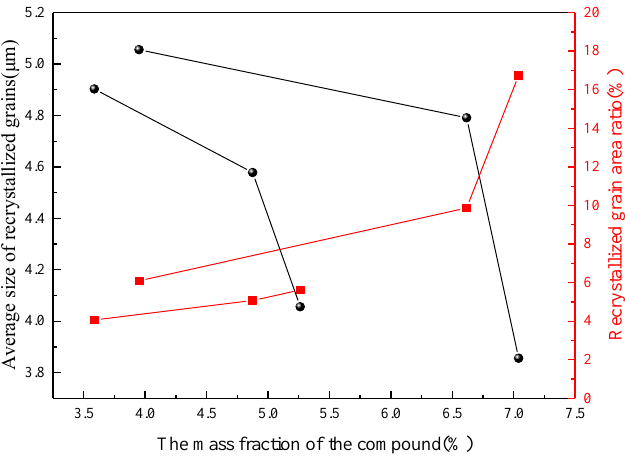
Figure 15. Influence of the number fraction of rare earth compounds on recrystallized grains.